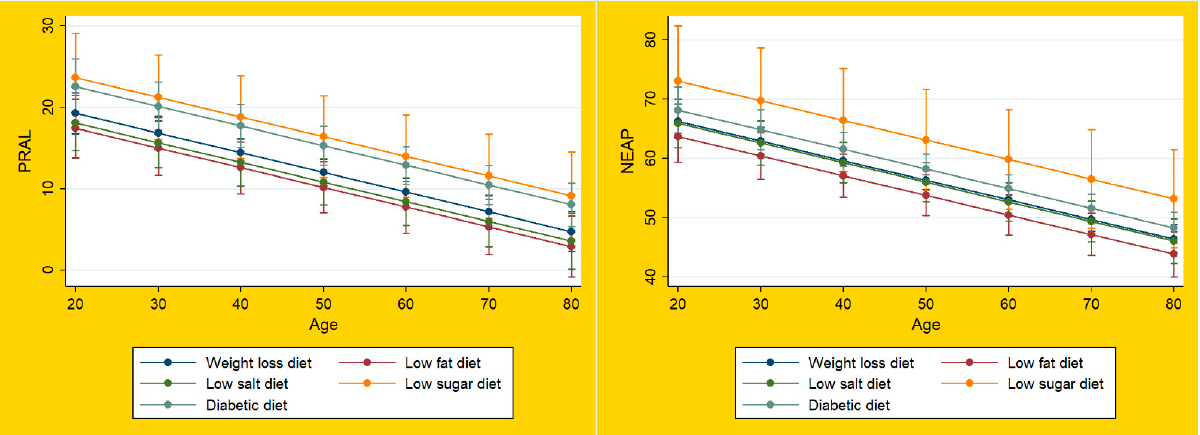
Figure 1. Dietary acid load of special diets in the NHANES. Legend for Figure 1: Plots of marginal predicted values based on the regression model, illustrating differences in the linear relationship of PRAL R and NEAP F and age, depending on each special diet